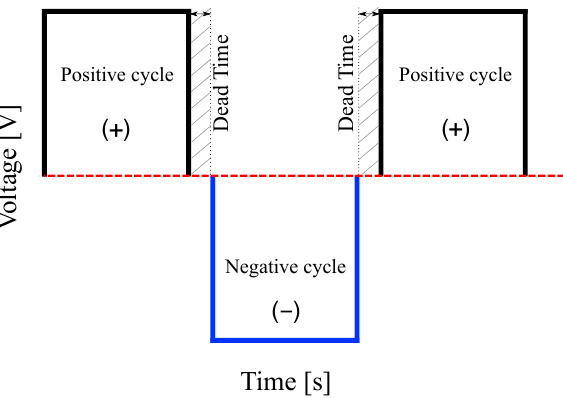
Figure 2. Balancing principle , output voltage of double-forward converter using dead